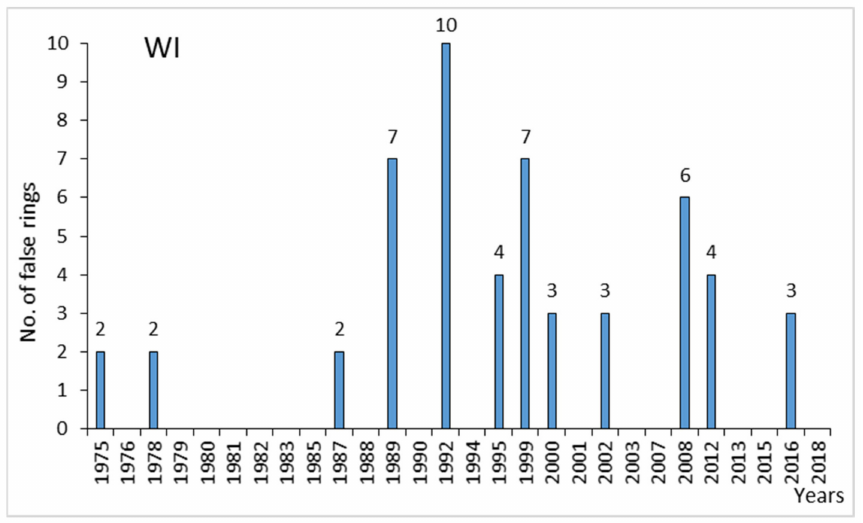
Figure 7. Number of false rings in Sawara cypress population at WI (shown are only false rings that occur in at least two trees in the same